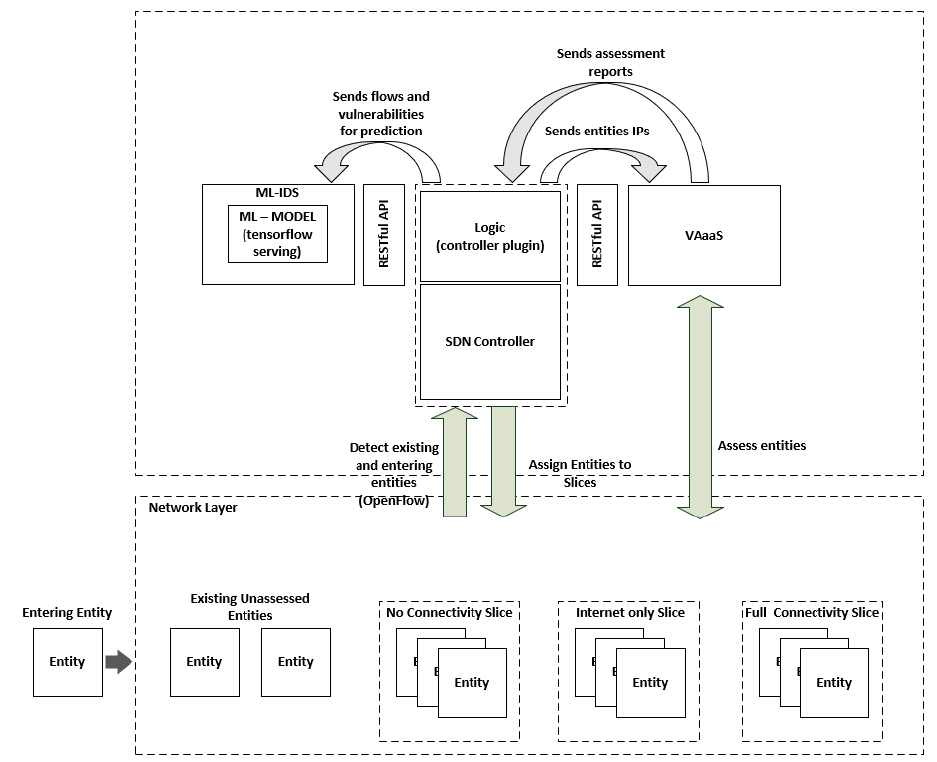
Figure 1. System architecture.